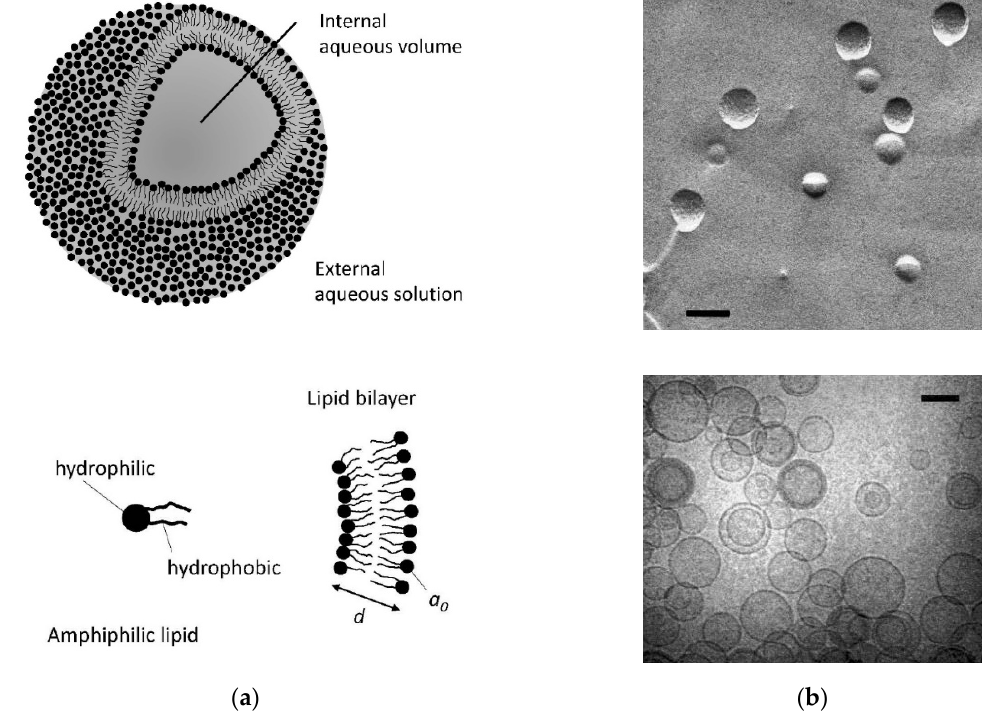
Figure 1. Phospholipid vesicles. ( a ) Schematic representation of a spherical unilamellar lipid vesicle. A self-closed bilayer of amphiphilic lipids forms the boundary of the vesicle, thereby entrapping a small internal aqueous volume. Assuming that the lipid is POPC, 1-palmitoyl-2-oleoyl- sn -glycero-3-phosphocholine, with an average head group area requirement ( a 0 ) of 0.63 nm 2 and a bilayer thickness ( d ) of 4 nm [19], a spherical unilamellar vesicle with a diameter of 100 nm consists of about 9.2 × 10 4 POPC molecules and has a trapped volume of about 4.08 × 10 − 19 L per vesicle, corresponding to 2.7 μ L/ μ mol POPC. For a dispersion of 1 mM POPC as ideal unilamellar vesicles of 100 nm diameter, the calculated vesicle concentration is about 11 nM and the total aqueous volume trapped by all vesicles present in 1 mL of this dispersion is 2.7 μ L only. ( b ) Freeze fracture electron microscopy ( top ) and cryo-TEM ( bottom ) images of a 20 mM POPC dispersion (50 mM Tris/HCl, pH = 8.0) prepared by polycarbonate membrane extrusion (final extrusions through membranes with 100 nm pores sizes, see Chapter 4) at T = 25 °C (bar: 100 nm). The vesicles were prepared in the presence of the highly water- soluble enzyme α -chymotrypsin; after removal of free enzyme at the conditions used in this previous work, each vesicle contained on average 87 entrapped α -chymotrypsin molecules (not visible on the electron microscopy images) [20]. The concentration of free, non-associated POPC was very low (~10 − 10 M; see Section 2.15). The electron microscopy images are reproduced with permission from [20], John Wiley & Sons, 1999.